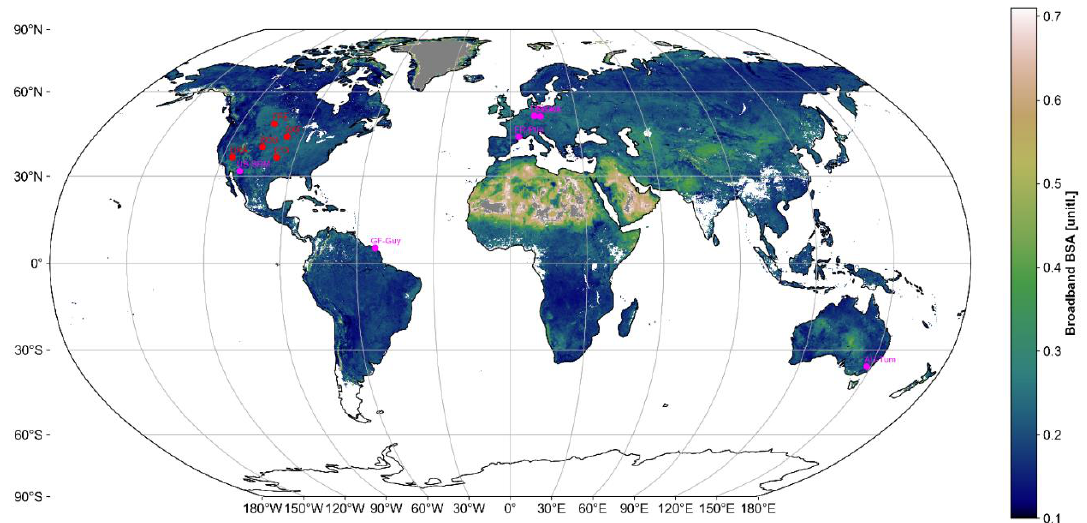
Figure 2. The retrieved broadband black-sky albedo for days of year 180–190 of the year 2010, based on a combination of MODIS and AVHRR observations. The BSRN sites marked with red circles, FLUXNET sites with magenta circles. Retrievals with albedo over 0.7 are marked with gray, as they are deemed unreliable based on a priori knowledge.